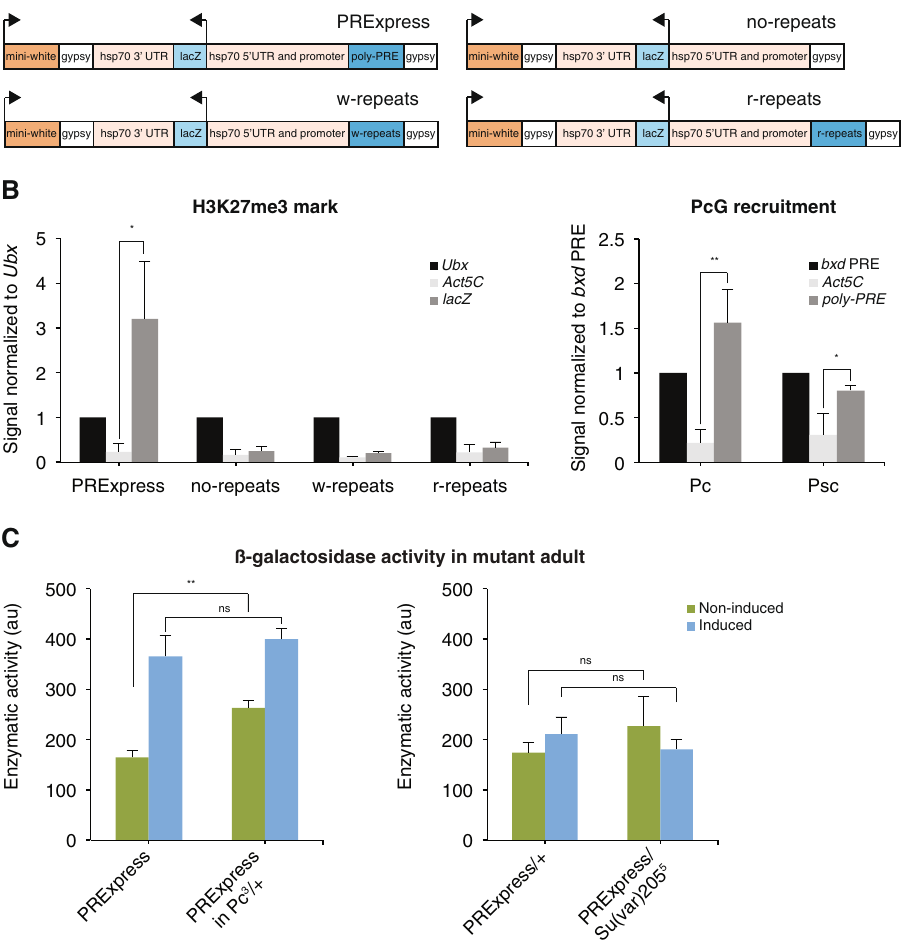
Figure 1. PRExpress in Drosophila . ( A ) Schematic view of transgenic constructs. In PRExpress, the lacZ coding sequence was placed under the control of hsp70 regulatory sequences. The poly-PRE sequence consisting of 8 repeats of a 198-bp fragment of the bxd PRE was placed upstream of the hsp70 promoter. This transgene was placed in the gypsy insulator bracket to reduce the potential repression of the mini-white marker gene. No-repeats control is similar to PRExpress but without any repeat sequences upstream of the promoter. In w-repeats and r-repeats controls, the poly-PRE sequence was replaced by 8 repeats of 198-bp fragments of the white gene and a random sequence, respectively. ( B , left ) Histone H3K27me3 mark at the reporter gene in PRExpress and no-repeats, w-repeats, and r-repeats control embryos. Chromatin immunoprecipitation (ChIP) results were normalized to Ubx gene values, a positive control. Act5C was a negative control. ( B , right) PcG recruitment at poly-PRE . Anti-Pc and anti-Psc ChIPs were normalized to bxd PRE, a positive control. Act5C was a negative control. ( C ) De-repression of PRExpress in heterozygous PcG and heterochromatin protein mutant backgrounds measured by β -galactosidase activity assay of whole adult protein extracts. The reporter was de-repressed in non-induced Pc 3 mutant background but not in Su(var)205 5 mutant background, affecting heterochromatin silencing. NS – P > 0.05, * P ≤ 0.05, ** P < 0.01, n =